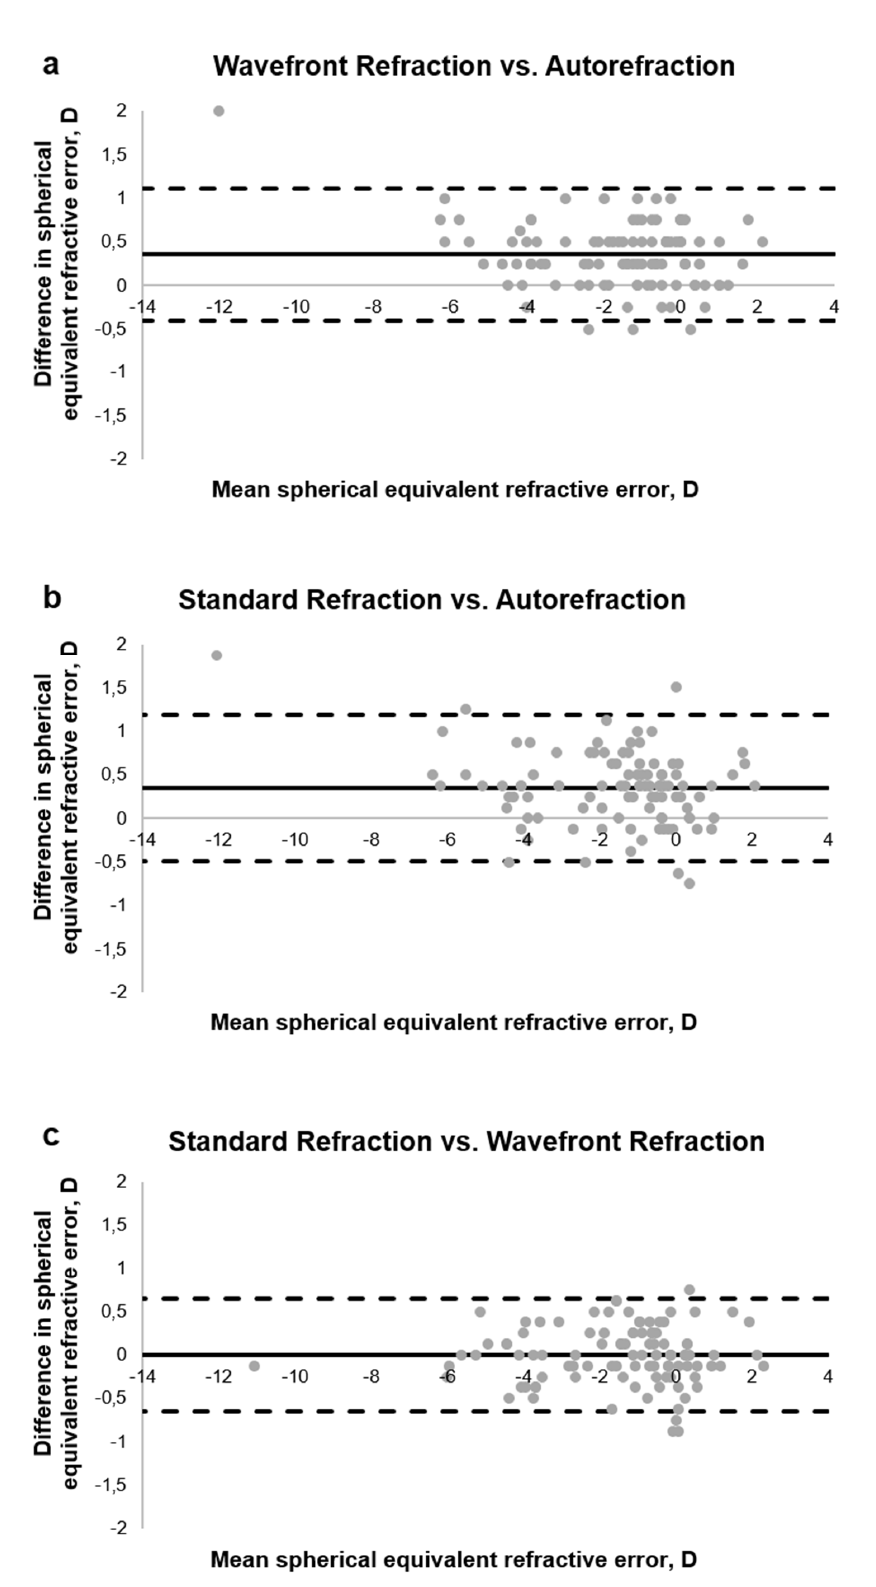
Figure 1. Bland–Altman plot for the comparison of the spherical equivalent refractive error after binocular testing with ( a ) Wavefront Refraction vs. Autorefraction, ( b ) Standard Refraction vs. Autorefraction, and ( c ) Standard Refraction vs. Wavefront Refraction.